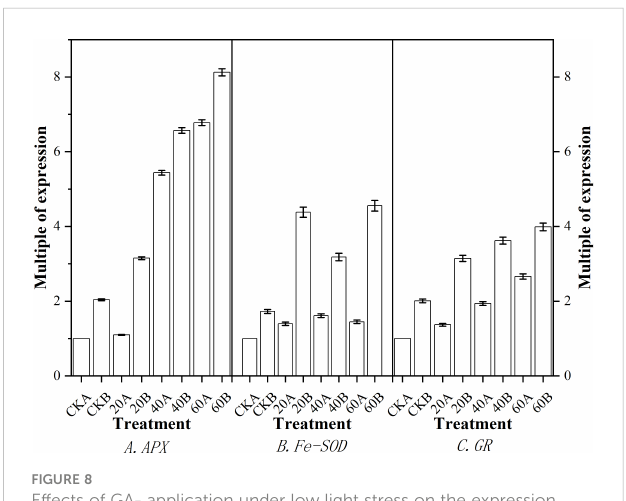
FIGURE 8 Effects of GA 3 application under low light stress on the expression levels of antioxidant-related genes in different light-sensitive inbred maize lines after shading for 15 days. (A) APX ; (B) Fe-SOD ; (C) GR . Values are expressed as mean ± SD of three replicates. Lower-case letters indicate the mean difference of different treatments in the same period, which is statistically signi fi cant